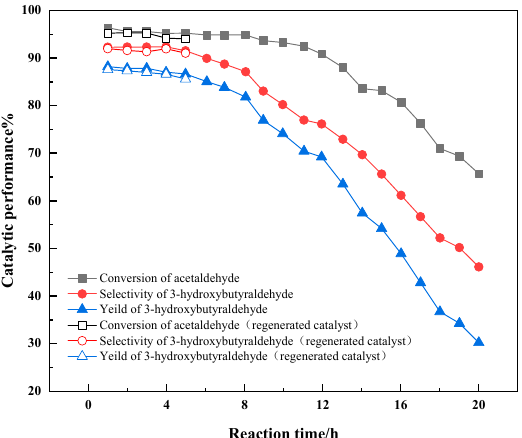
Figure 10. Lifetime of composite oxides 0.5%La ‐ 2.3%Ca ‐ 2MgO/Al 2 O 3.